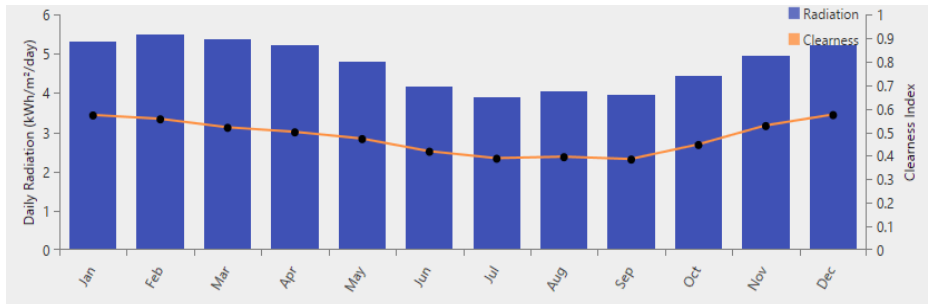
Figure 5. Irele solar